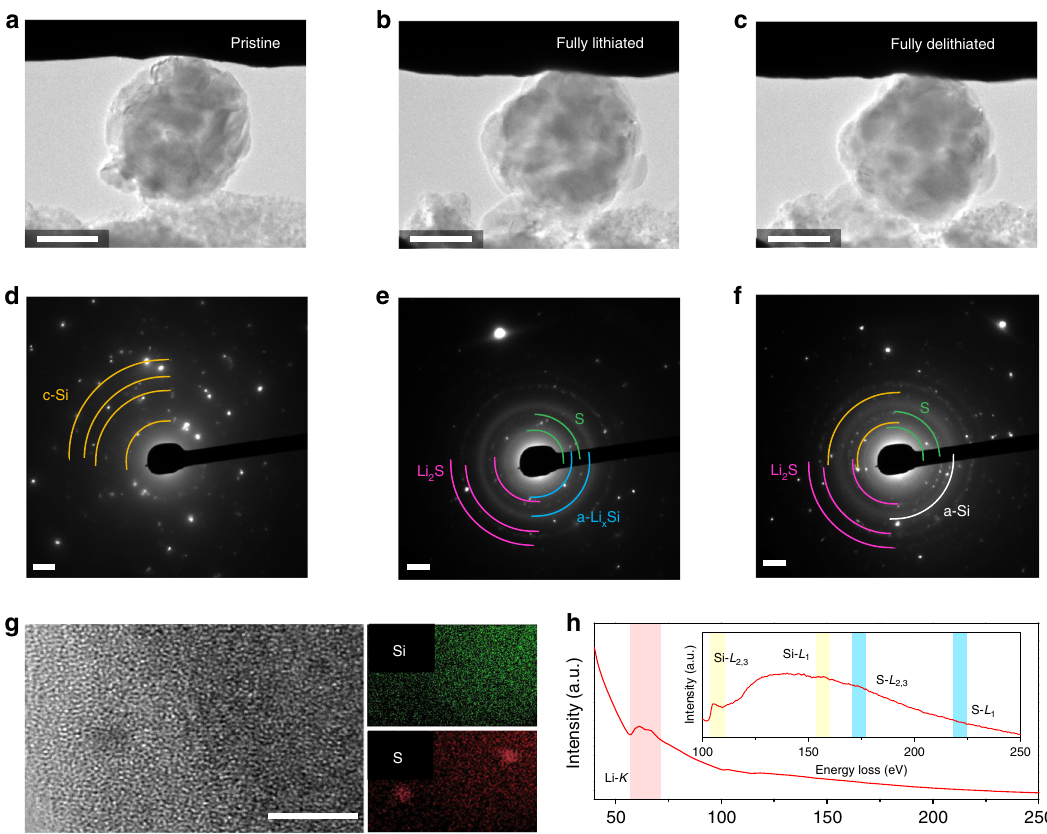
Fig. 4 Lithium sul fi de formation inside quasi-metallic silicon. a – f TEM images, and corresponding selected area diffraction patterns for ( a , d ) pristine, ( b , e ) fully lithiated, and ( c , f ) fully delithiated states of QMS particle. g , h HR-TEM image and corresponding elemental maps for Si and S ( g ) and EELS spectrum ( h ) of QMS after cycles and SEI elimination. Scale bars, 500 nm ( a , c , e ); 2 1/nm ( b , d , f ); 5 nm ( g